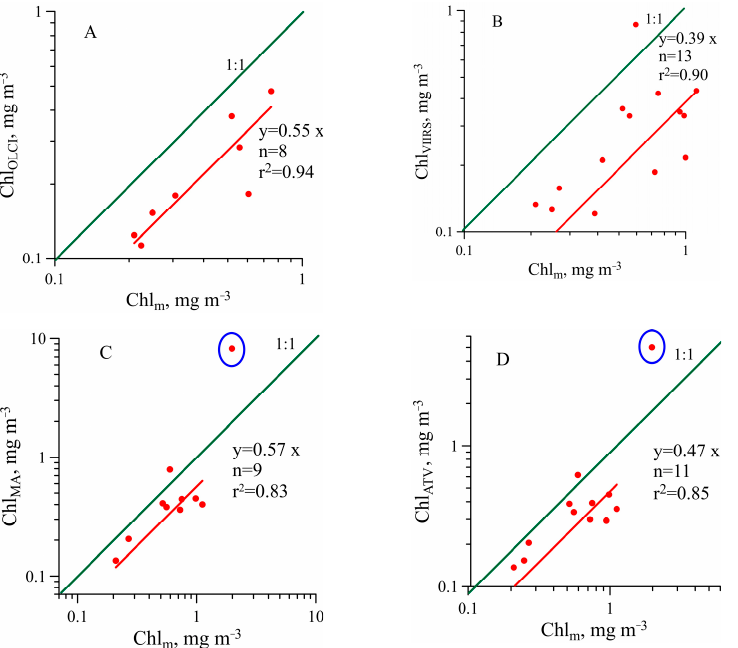
Figure 15. Comparison of the satellite chlorophyll a concentration Chl and the concentration measured in situ (Chl m ). The green line 1:1 represents an ideal correspondence: ( A )—S3A-OLCI data (Chl OLCI ), ( B )—SNPP-VIIRS data (Chl VIIRS ), ( C )—Aqua-MODIS data (Chl MA ) and ( D )—Merged_ATV data (Chl ATV ). The red line represents the correlation between Chl m and satellite data without one maximal satellite value—dot in the blue circle ( C , D ). Table 3. Validation of satellite (Merged ATV, Aqua-MODIS, S3A-OLCI, SNPP-VIIRS) chlorophyll a retrieval based on statistical metrics: bias (Equation (3)) and MAE (Equation (4)). Satellite Scanners n bias MAE Merged ATV 12 0.63 Aqua-MODIS S3A-OLCI SNPP-VIIRS without maximum value (one point highlighted in Figure 15) Merged ATV